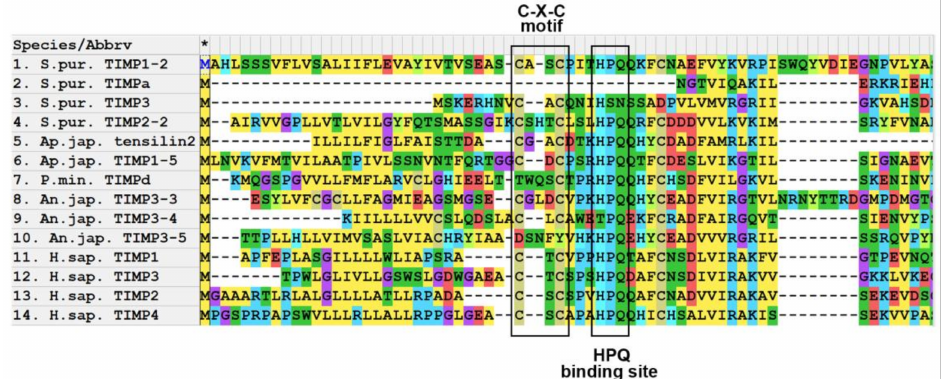
Figure 7. MUSCLE (MegaX) alignment of N-terminus of amino acid sequences of some TIMPs of echinoderms and